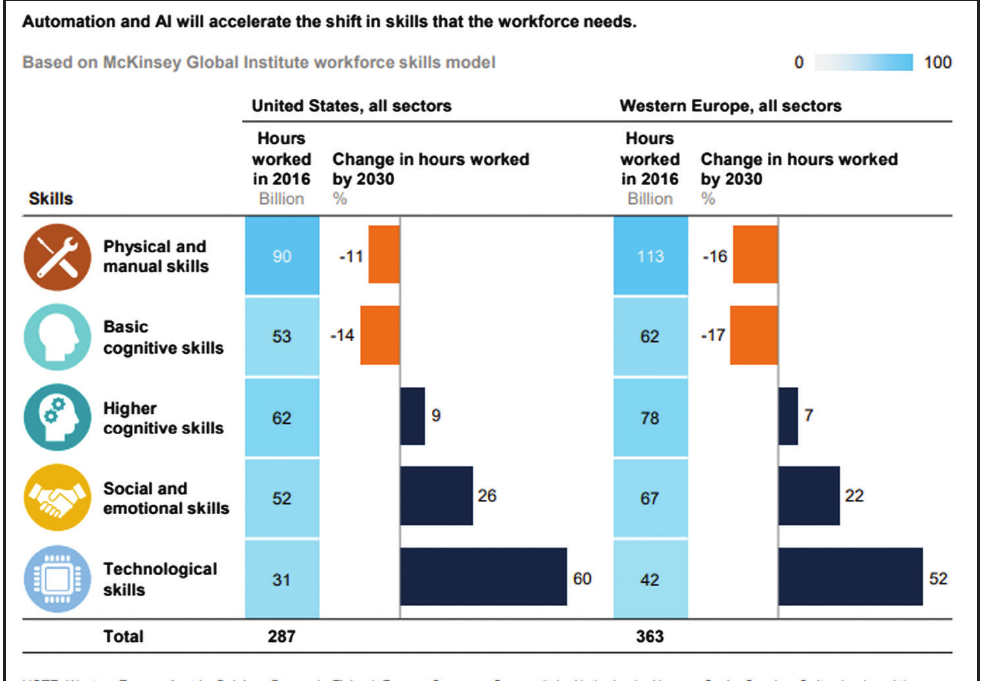
Predicted shifts in skill sets, United States vs. Western Europe, 2016–2030